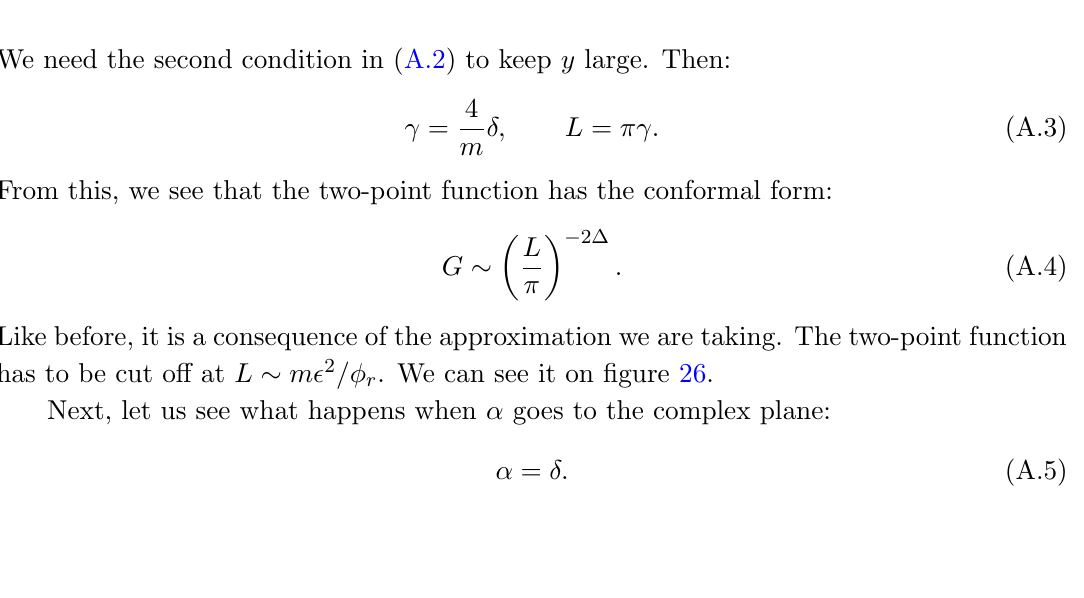
Figure 27 . (cid:13) ( u 12 ) for negative mass. The conformal result (cid:13) (cid:24) sin u 12 is the dark blue line on the bottom. The red line corresponds to the largest